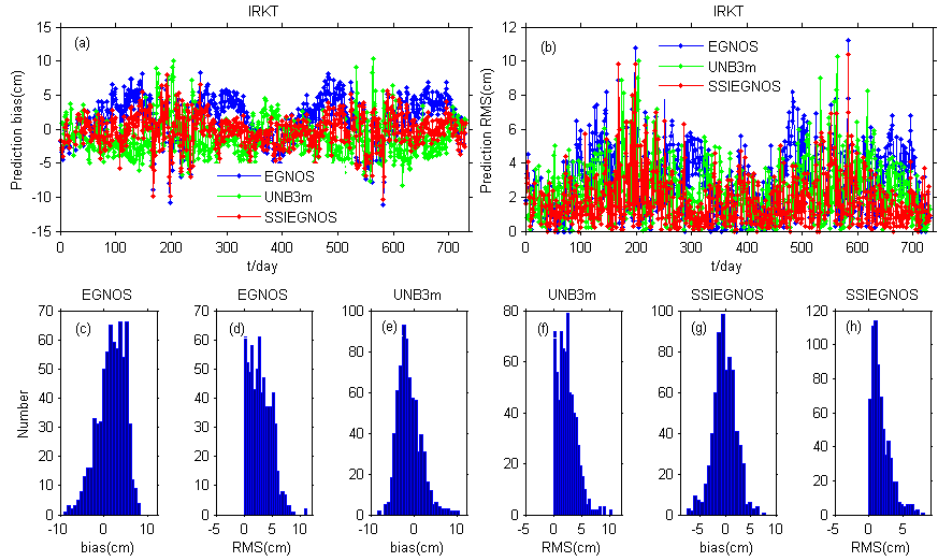
Figure 12. ( a , b ) Time series of daily predicted bias and RMS from 2011–2012 at the IRKT site. The blue line denotes the EGNOS model, the green line denotes the UNB3m model, and the red line denotes the SSIEGNOS model. ( c – h ) Histograms of the daily predicted bias and RMS error from 2011–2012 for the three models, respectively.